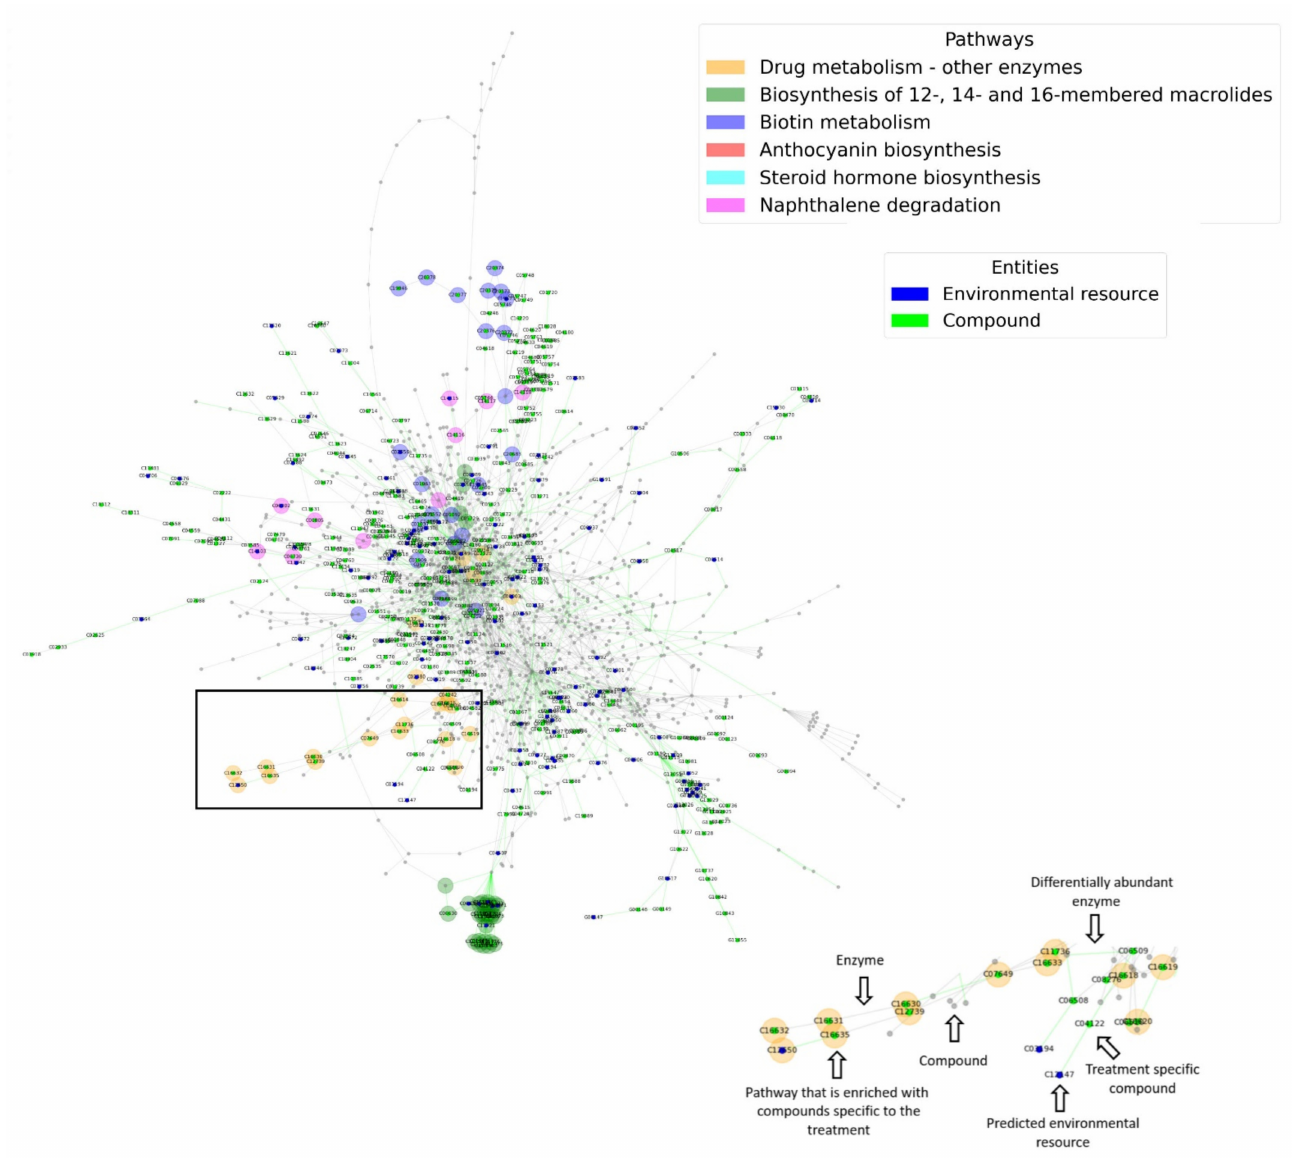
Figure 3. 2-D visualization of the metabolic network formed based on metagenomics data. Edges represent enzymes; nodes represent metabolites. Colored edges represent differentially abundant enzymes; Colored edges represent differentially abundant enzymes; colored nodes represent environmental resources and treatment-specific compounds (colors and iterations are selected by the user). Nodes’ background colors (wider circles around the nodes) represent pathways that are enriched (FDR adjusted p -Value ≤ 0.05) with network components (nodes) that are unique to the treated